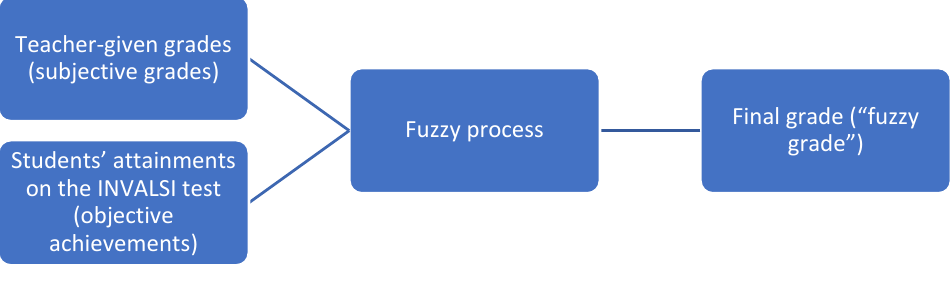
Figure 1. The fuzzy process.